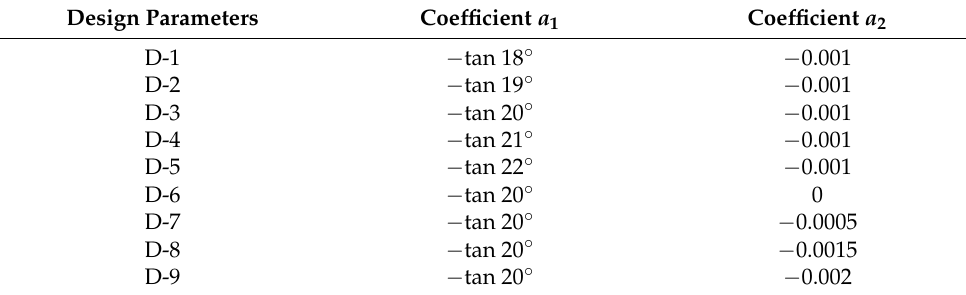
Table 2. Coefficients of the contact path